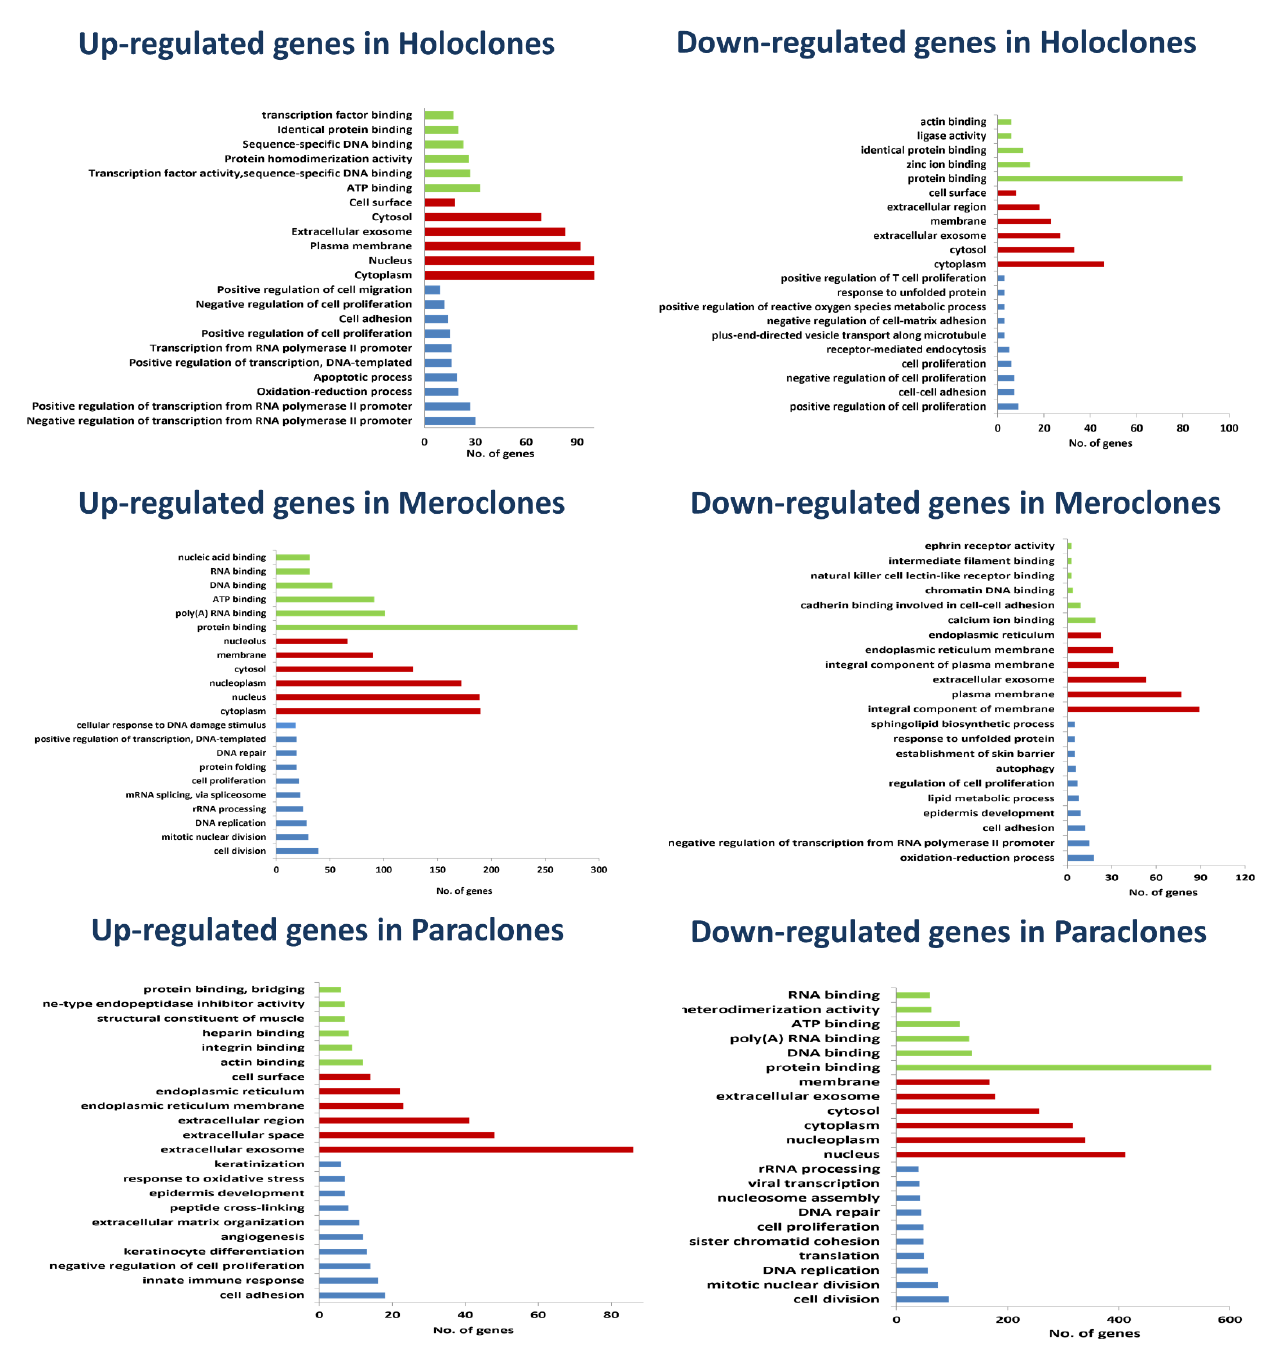
Figure 3. Gene ontology of the signature differentially expressed genes. The DEGs in holoclones, meroclones, and paraclones were annotated into three major functional categories: biological process (blue bars), cellular component (red bars), and molecular function (green bars). The X-axis indicates the names of GO terms (Direct level) and the Y-axis indicates the number of genes.